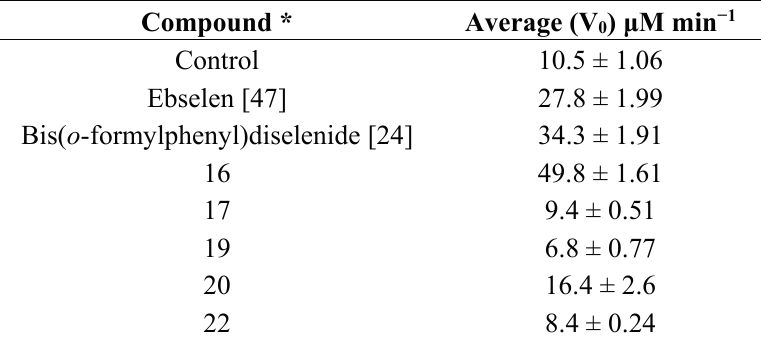
Table 1. Glutathione peroxidase-like activity of organoselenium compounds determined by coupled reductase